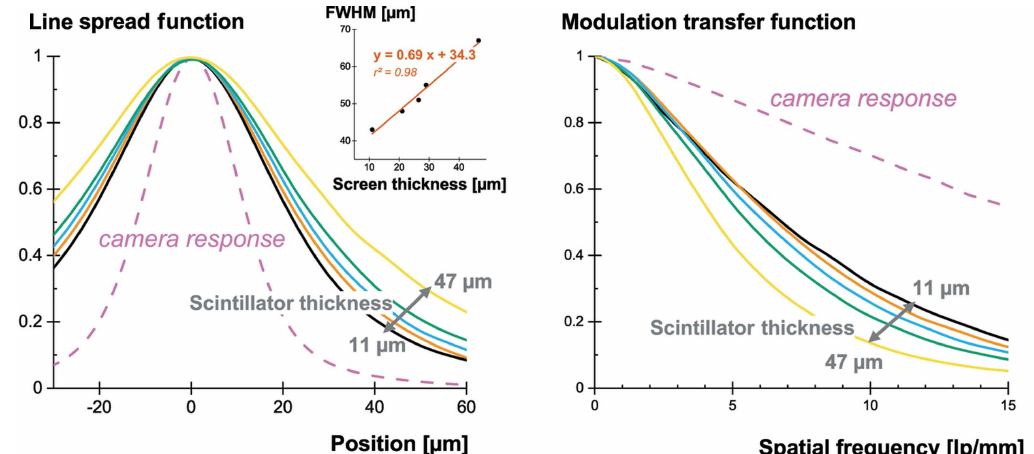
Figure 7 LSF, FWHM (inset) and MTF of the GOS:Tb scintillating screens. The system response of the camera is provided for information.